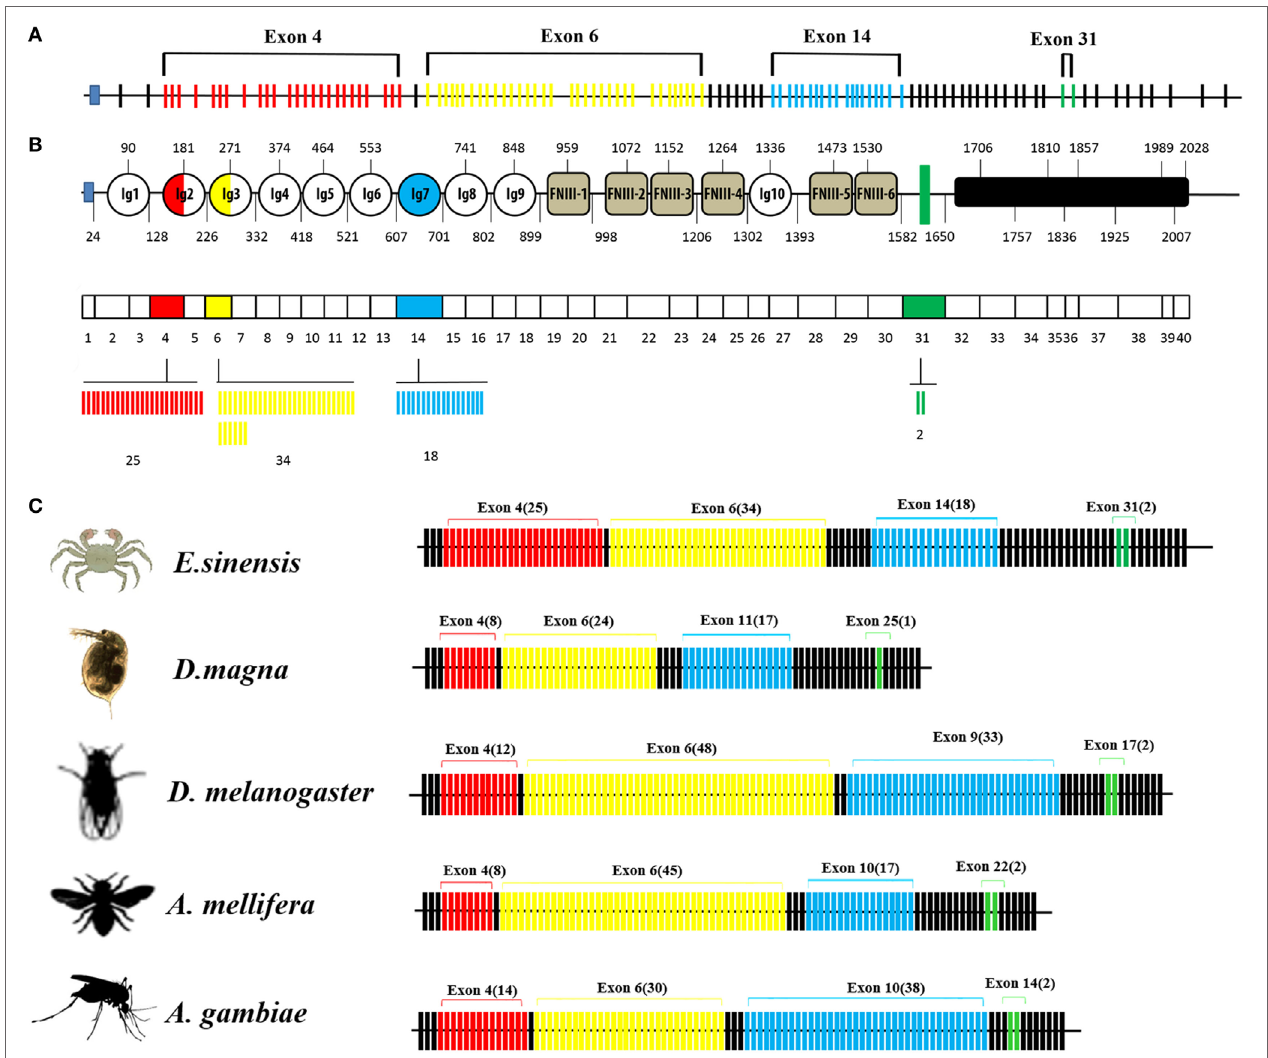
FigUre 1 | Genome structure of Dscam gene. (a) Eriocheir sinensis Dscam genomic DNA structure. Es Dscam mRNA comprises 40 exons (short lines); 36 constant exons are indicated by black lines and 4 hypervariable exons are indicated by colored lines. Exon 4 contains 25 variants (red), exon 6 contains 34 variants (yellow), exon 14 contains 18 variants (blue), and exon 31 contains 2 variants (green). (B) Es Dscam protein domain and mRNA structure. ( Upper panel ) The alternatively spliced exons encode the N-terminal half of Ig2 (red semicircle) and Ig3 (yellow semicircle), all of Ig7 (blue circle), and the transmembrane domain (green rectangle); ( middle panel ) constant exons are shown as white boxes and the mutually exclusive alternative splicing exons are shown in the same color scheme as that used for the protein structure. Es Dscam mRNAs contain only one of each of the alternative splicing exons; ( lower panel ) the variant numbers of mutually exclusive alternative splicing exons are indicated by colored lines using the same color scheme as that used for the protein structure. (c) Comparison of Dscam gene within arthropod species. The number of exons is shown. Black lines represent constant exons. The hypervariable exons in the exon 4, 6, 9, and 17 clusters of Drosophila melanogaster are shown in red, yellow, blue, and green, respectively. The number of variable exons within each array in each species is displayed above each array. The exon 10 arrays of Anopholes gambiae and A. mellifera , the exon 11 array of D. magna and the exon 14 array of Eriocheir sinensis correspond to the exon 9 array of Drosophila . Similarly, the exon 14 and 22 arrays of A. gambiae and A. mellifera , the exon 25 array of D. magna and the exon 31 array of E. sinensis correspond to the exon 17 array of Drosophila